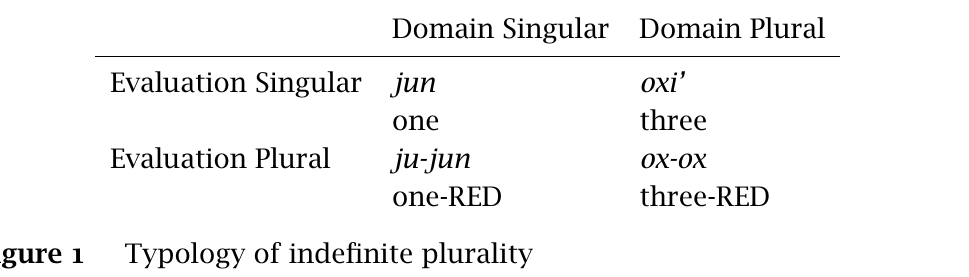
Figure 1 Typology of indefinite